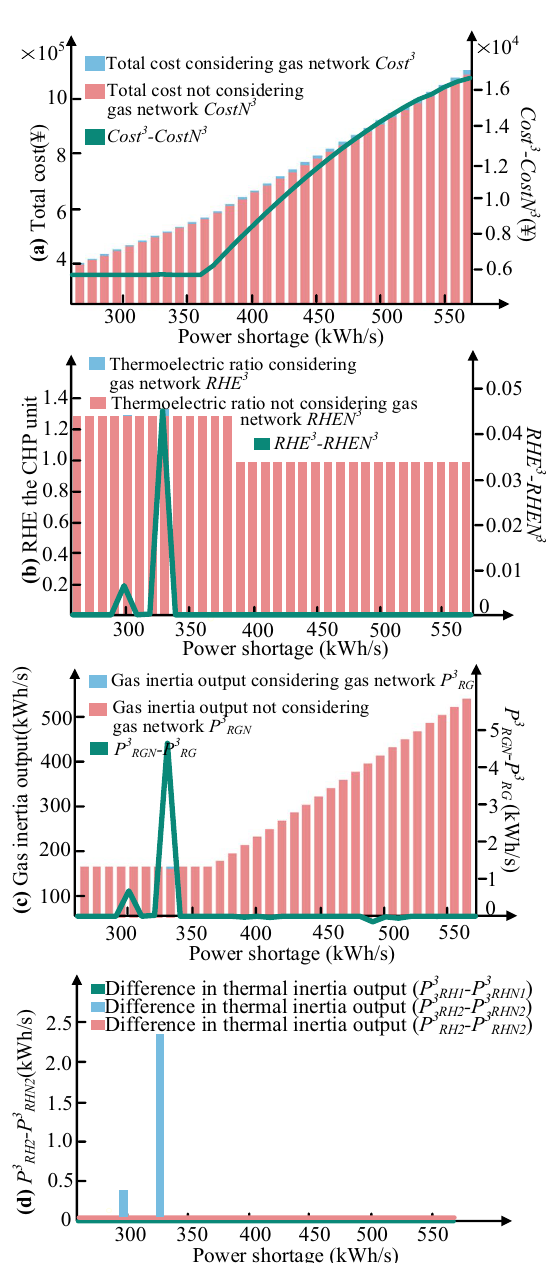
Fig. 12 Comparison results with power shortages at L